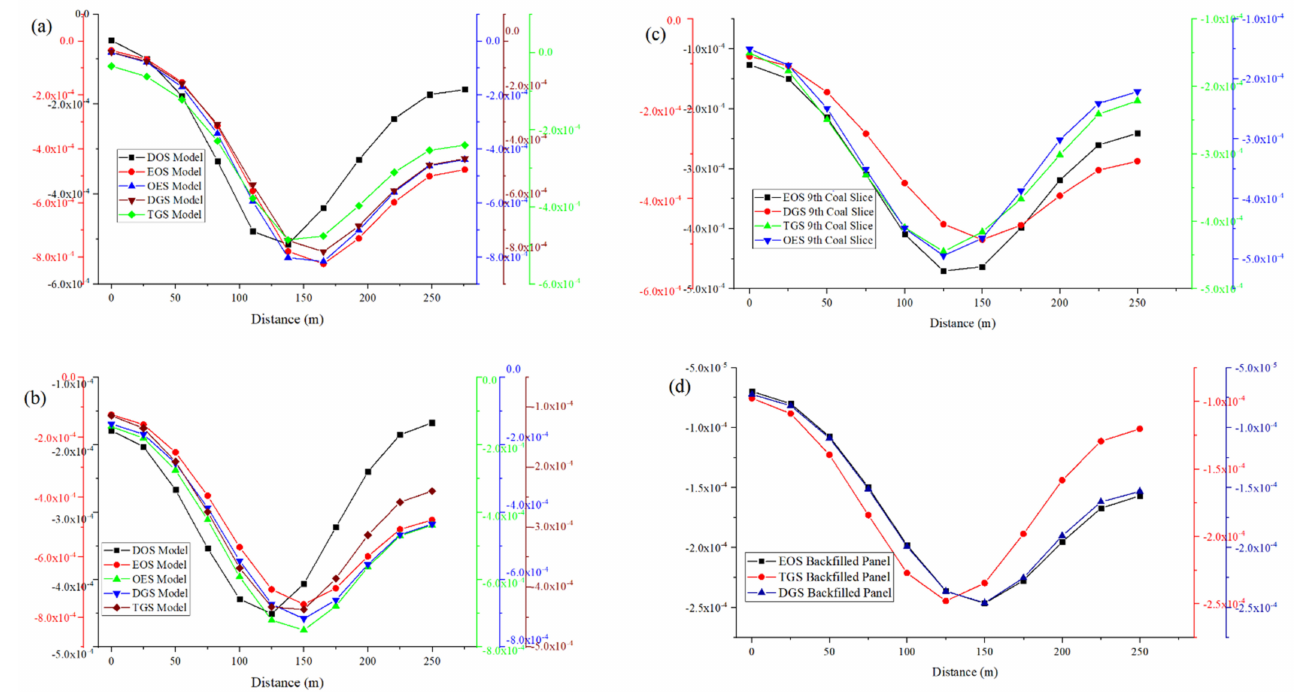
Figure 12. Vertical displacements. ( a ) Immediate roof displacement; ( b ) ground surface displacement; ( c ) 9th coal slice excavated and backfilled; ( d ) 12th coal slice excavated and